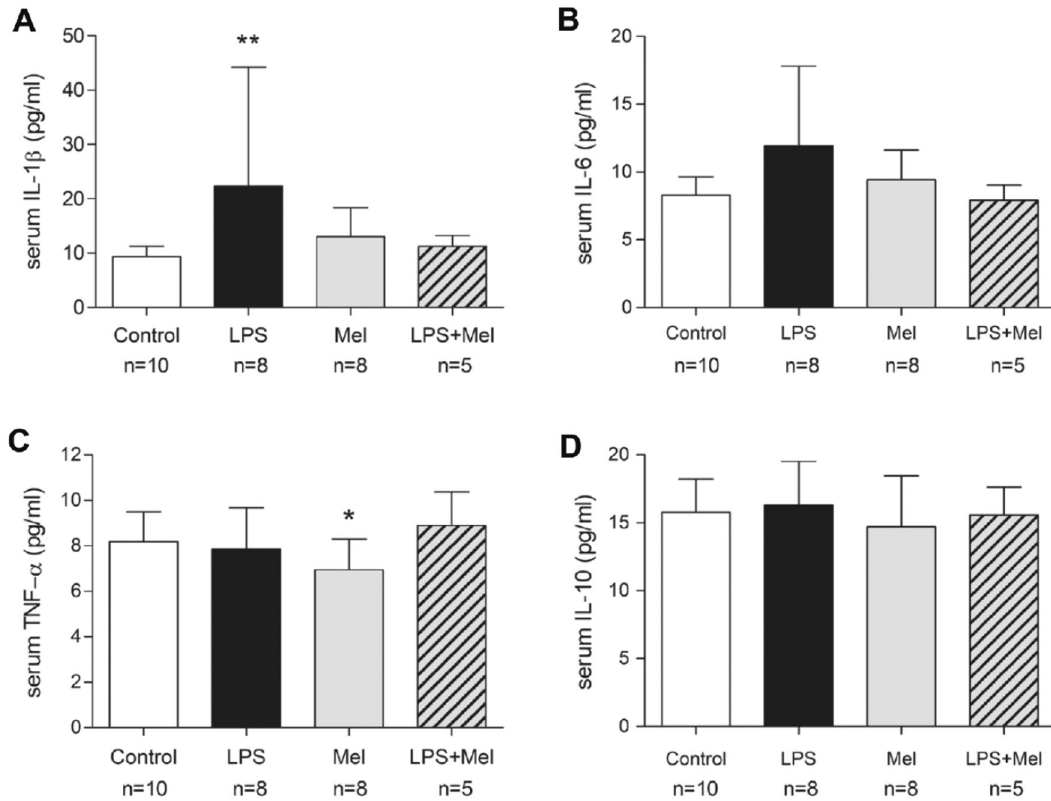
Figure 2. Melatonin prevented the LPS-induced inflammation in rat pup sera at PND1. Serum cytokine concentration in pg/ml were measured in pups at PND1 by multiplex assay. Each graph reports one cytokine measurement, i.e., IL-1β ( A ), IL-6 ( B ), TNF-α ( C ) and IL-10 ( D ). These measurements were performed according to our four experimental groups, i.e., the Control (Control), the liposaccharide portion of the E. coli membrane (LPS), the melatonin (Mel) and the LPS + Mel groups. Results are expressed as mean (bold line) ± standard deviation. Statistical analysis: One-Way-ANOVA test was performed associated with Bonferroni post-test, * p < 0.05 and ** p < 0.01 in comparison with the Control Melatonin showed variable preventive effects on GABAergic neurons after LPS challenge depending on the grey matter region. LPS did not show any significant effect on the GABAergic neu- ron population of the dentate gyrus at PND7 and at PND21 ( p = 0.43 and p = 0.5 in comparison with the Control group, respectively). However, melatonin induced a significant and sustainable increase in GABAergic neurons in rats exposed to the LPS challenge (LPS + Mel group) ( p = 0.004 at PND7 and p = 0.03 at PND21 in comparison with the LPS group, respectively) (Fig. 3A–C). This rise in GAD65/67-positive cells was only significant at PND7 in the LPS + Mel rats in comparison with the Control rats ( p = 0.0008) (Fig. 3A). A significant decrease in the GAD65/67-positive cells was observed within the retrospenial cortex in brains of PND7 rats exposed to LPS ( p = 0.02 in comparison with the Control group) (Fig. 3D). Conversely, the GAD65/67- positive cells were significantly more numerous within the retrospenial cortex of PND21 brains in the LPS group ( p = 0.01 in comparison with the Control group) (Fig. 3E,F). Melatonin prevented the LPS effect at PND7 and restored the GAD65/67 population within the retrospenial cortex ( p = 0.0008 in comparison with the LPS group) (Fig. 3D). At PND21, melatonin in association with LPS demonstrated no specific effect and resulted in a similar increase in the GAD 65/67 population as in the LPS group ( p = 0.002 in comparison with the Control group and p = 0.56 in comparison with the LPS group, respectively) (Fig. 3E,F). In the caudate-putamen region at PND21, the GABAergic neuron responses to LPS and/or to melatonin were similar to those observed in the retrospenial cortex at PND21 ( p = 0.001 in comparison with the Control group and p = 0.46 in comparison with the LPS group) (Fig. 3G,I). Melatonin failed to prevent alterations of the oligodendrocyte lineage induced by the LPS challenge. Significant reductions in the OPCs and the early Pre-OLs stained by NG2 antibody were observed within the external capsule in the brains of PND1 pups exposed to the LPS and to the LPS + Mel chal- lenges ( p = 0.03 and p = 0.04 in comparison with the Control group, respectively) (Fig. 4A,B). These decreases were transient as the NG2-positive cell populations were completely restored within the external capsule in the PND7 brains (Fig. 4C).